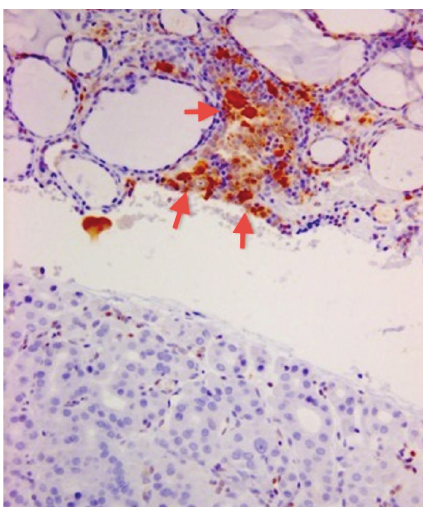
Figure 2: Immunohistochemical features. It should be noted that also Hashimoto thyroiditis may show reactivity for Galectin-3, but it is typical focal and restricted to epithelial cells in the areas of lymphocytic infiltrations. Gal-3 in OA: compare the negative tumor with the positive macrophages (top, arrows).